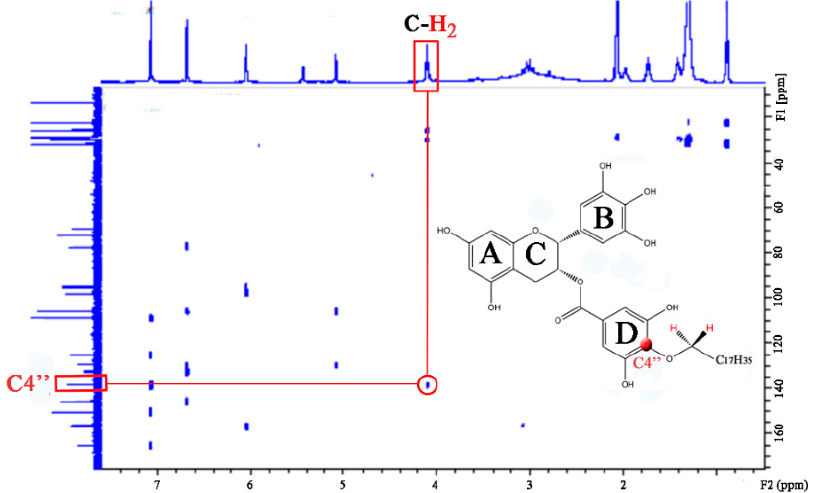
Figure 2. HMBC (Heteronuclear Multiple-Bond Connectivity Experiment). Cross-peak between C4” and methylenic protons of C18 chain directly bound to the oxygen in C4”.